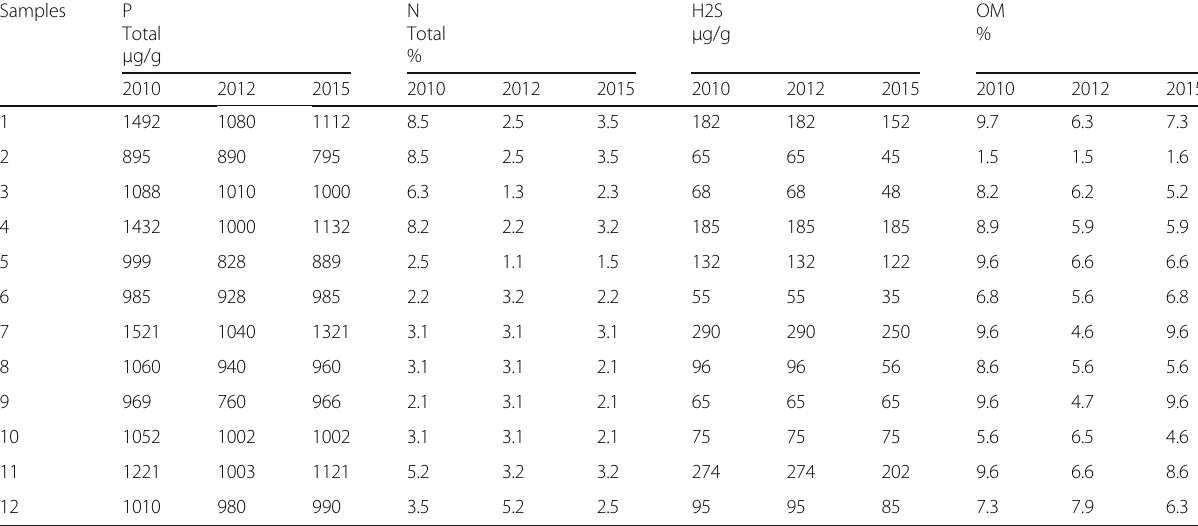
Table 9 Bottom sediments with P, N, H2S, and OM in EL-Burullus Lagoon 2010 – 2015